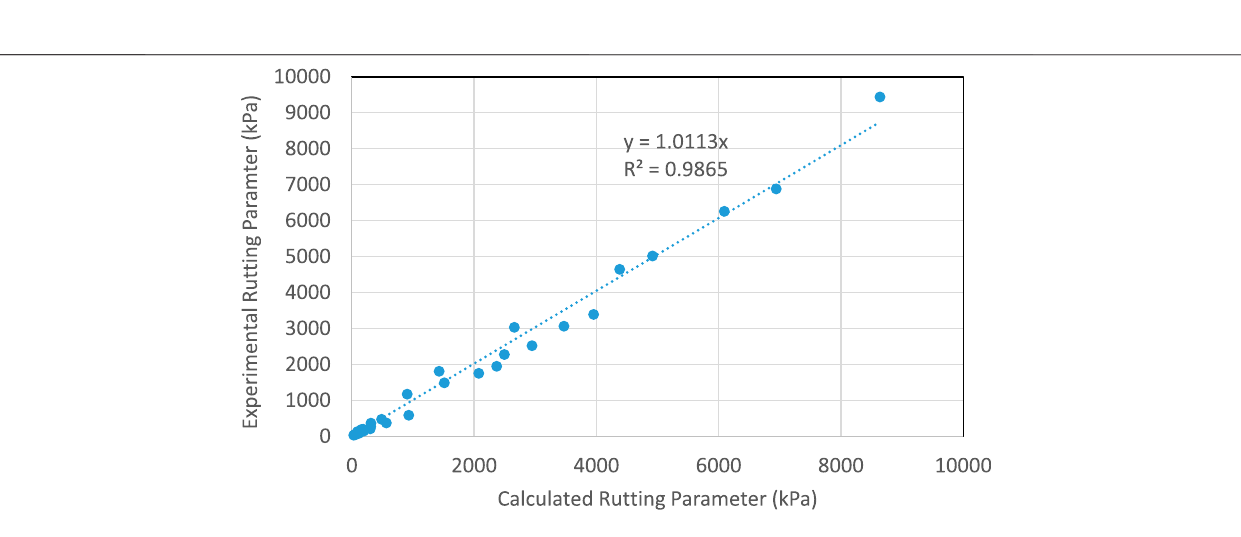
FIGURE 6 | Predicted vs. experimental rutting parameter for the unaged unmodi fi ed CMAs: Modeling points.